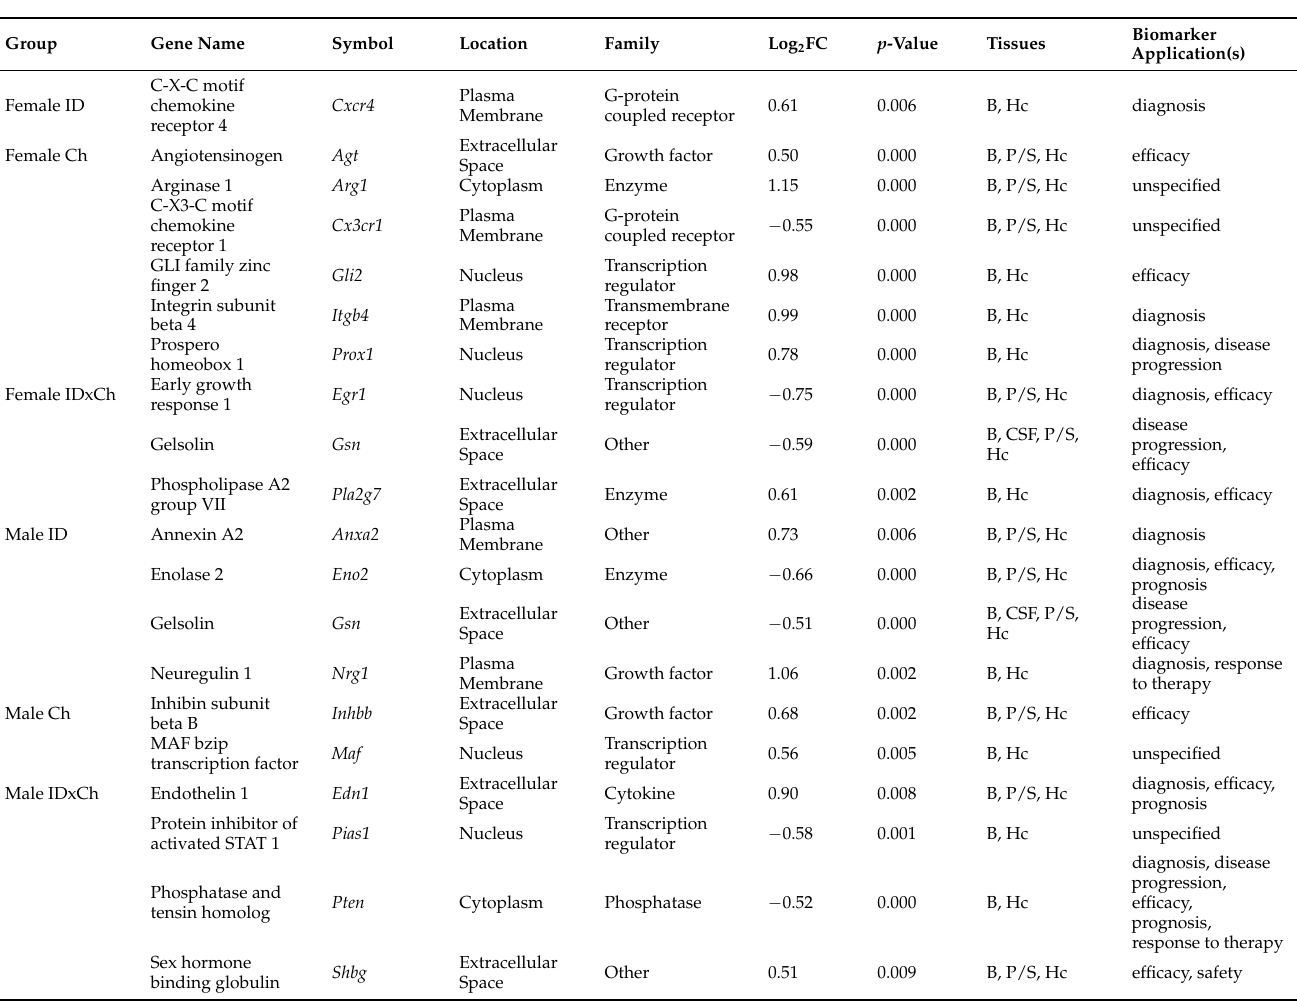
Table 1. IPA-mapped known biomarkers found in humans, mice and